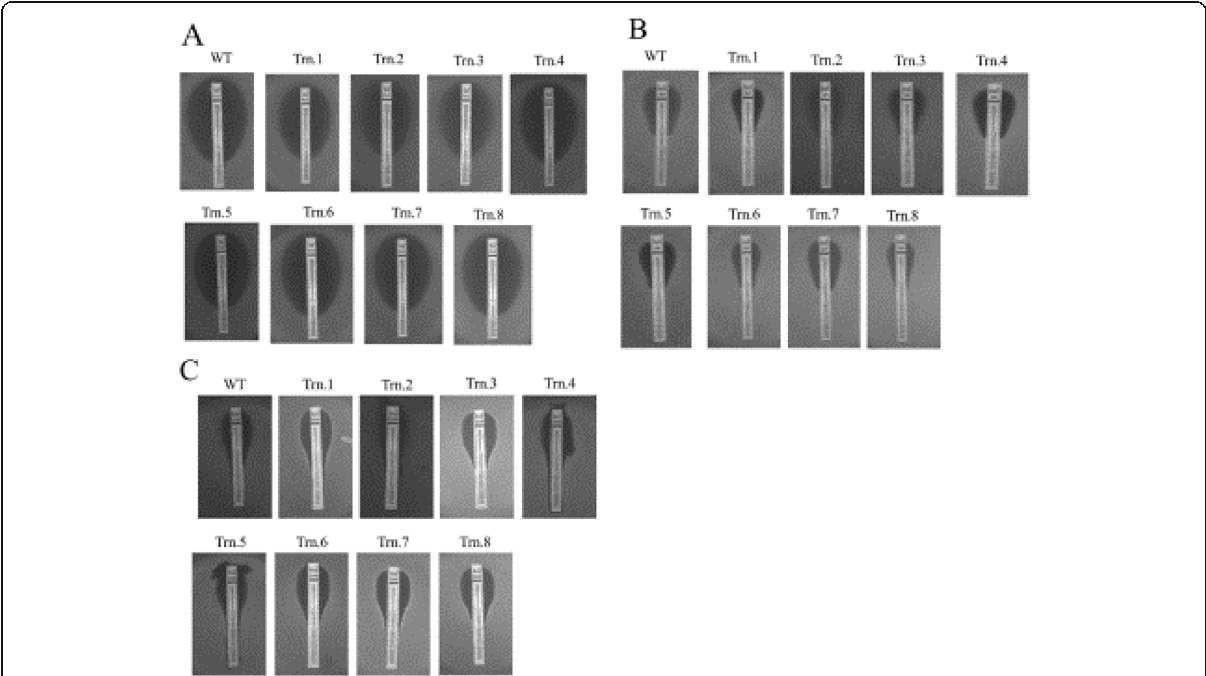
Fig. 3 Minimum inhibitory concentration (MIC) assay for strains carrying truncated Chr4. WT, wild type strain CAF4-2; Trn.1 to Trn.8, Candida strains carrying truncations 1 – 8. MIC strip test for the strains against A fluconazole in the range of 0.016 – 256 μ g/ml; B amphotericin B in the range of 0.002 – 32 μ g/ml; C caspofungin in the range of 0.002 – 32 μ g/ml. Strains with truncated Chr4 showed MIC values similar to the wild